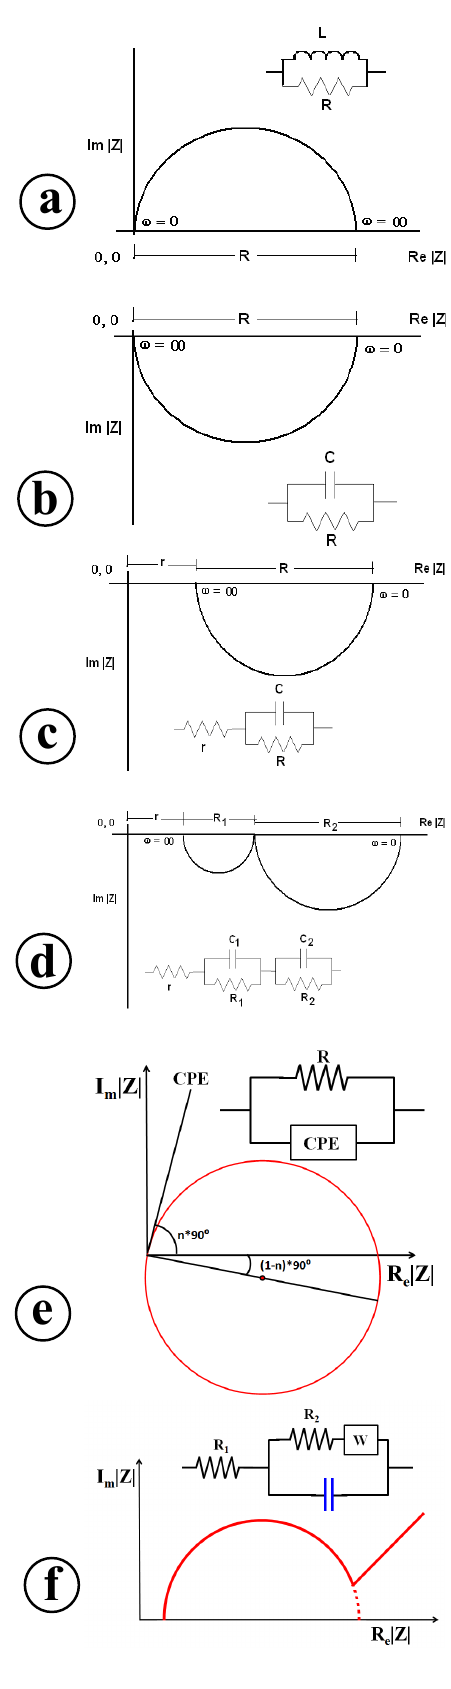
Figure-2: Nyquist plots for different circuit combinations: (a) R and L in parallel, (b) R and C in parallel, (c) r in series with (R and C in parallel), (d) r in series with (R and C in parallel) and (R and C in parallel), (e) R and CPE in parallel, (f) R 1 in series with the parallel combinations of (R 2 in series with W) and